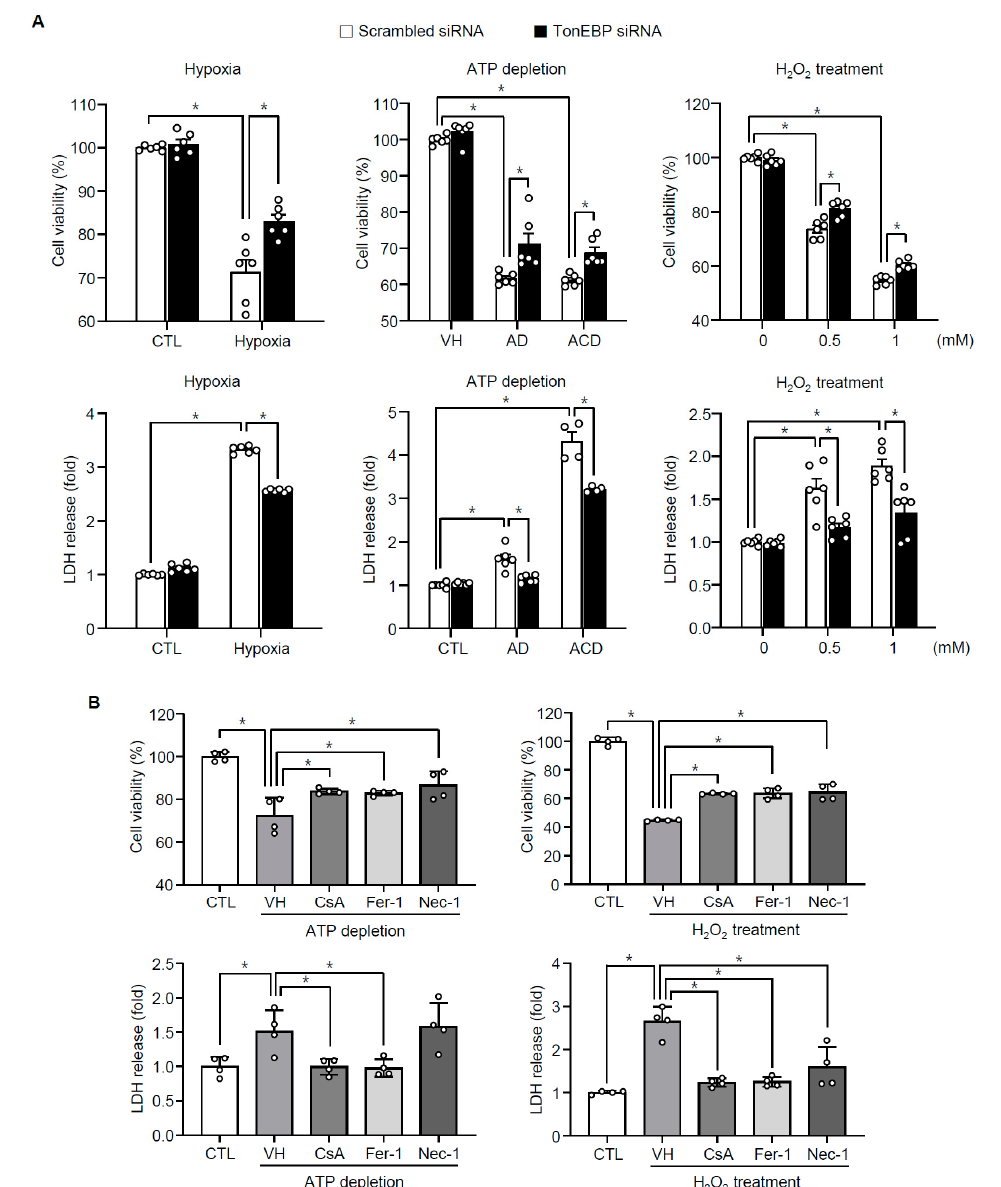
Figure 5. Effects of TonEBP knockdown and inhibitors on cell viability and release of lactate dehydrogenase (LDH). ( A ) HK-2 cells were transfected with TonEBP targeted siRNA (filled bars) or scrambled (non-targeting) siRNA (open bars). Cells were then incubated with hypoxia (1% O 2 ) for 24 h, ATP depletion (AD—10 μ M of antimycin A and 10 mM 2-deoxy- D -glucose, or ACD—10 μ M of antimycin A, 10 mM 2-deoxy- D -glucose and 1 μ M of ionomycin) for 3 h, or H 2 O 2 treatment for 1 h. ( B ) Cells were pretreated for 60 min with vehicle (VH), cyclosporin A (CsA, 1 μ M), ferrostatin-1 (Fer-